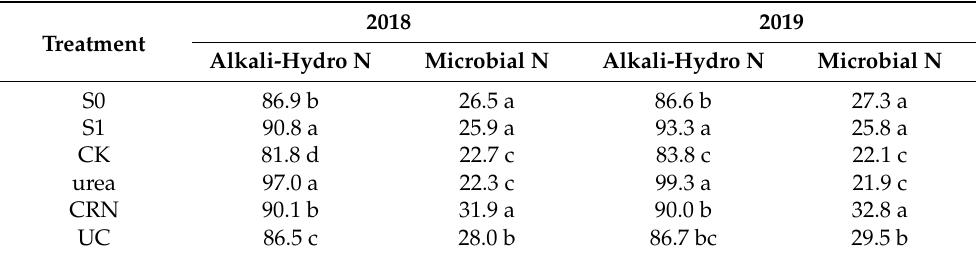
Table 5. Effects of straw management combined with N-fertilization strategy on soil alkali-hydro N and microbial N contents at harvest (mg kg − 1 ).